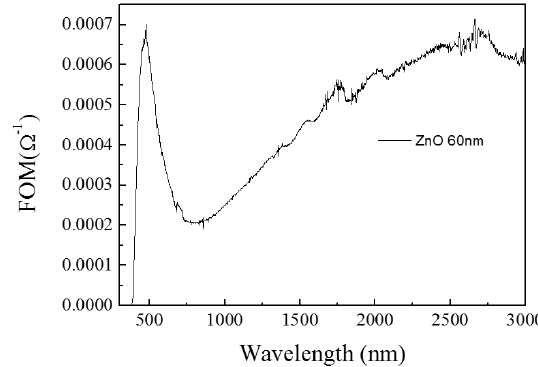
Figure 2. The figure of merit of ZnO/glass complex films for different thickness.